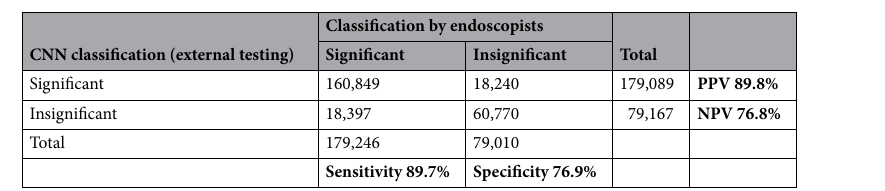
Table 4. Classification results of manually labeled images by the CNN. The contents marked in bold indicate the accuracy of the algorithm. PPV positive predictive value, NPV negative predictive value.